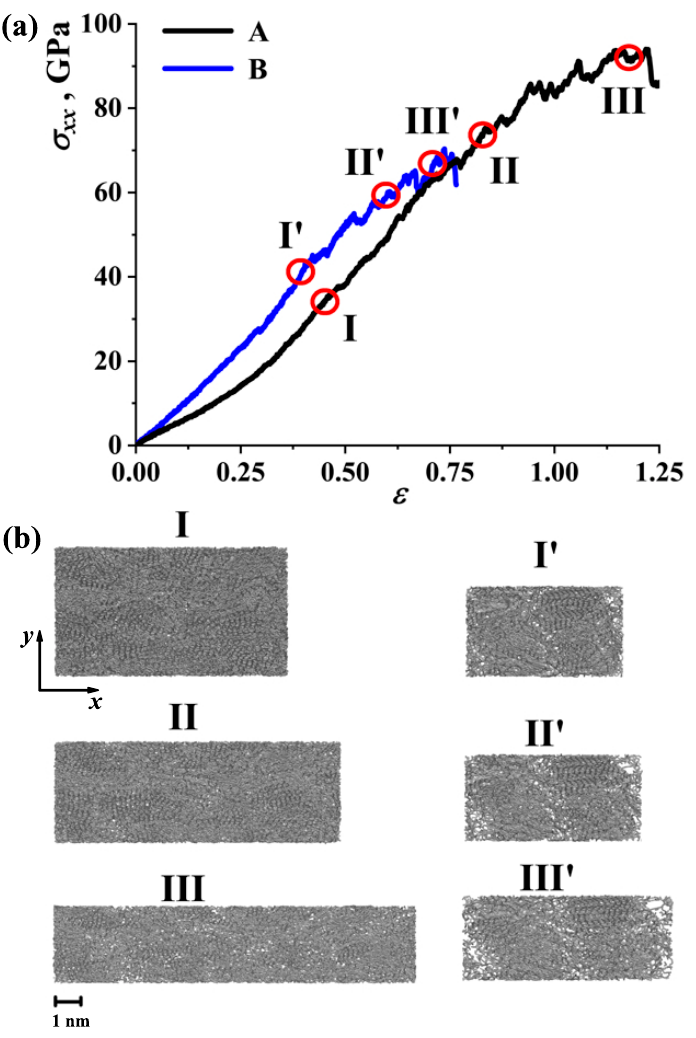
Figure 4. ( a ) Stress–strain curves during tension under uniaxial tension along x for crumpled graphene fibers of two morphologies. ( b ) The snapshots of the surface of structure at critical points. The snapshots of the structure surface at critical points during tension along the x -axis are presented. Since periodic boundary conditions are applied, there was no